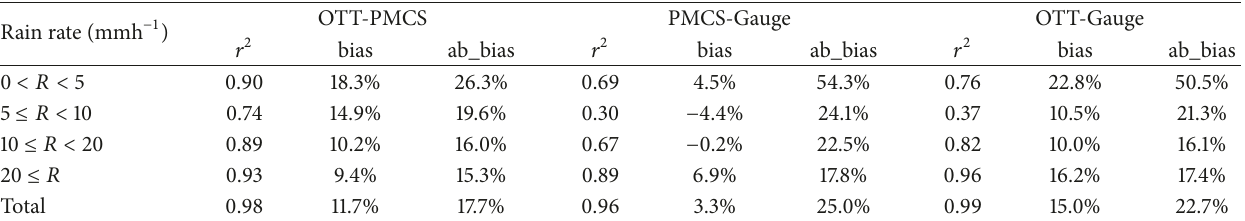
Table 4: Variances of rain intensity obtained from the PMCS, OTT, and Gauge (𝑟 2 represents the correlation coefficients ) . Rain rate (mmh −1